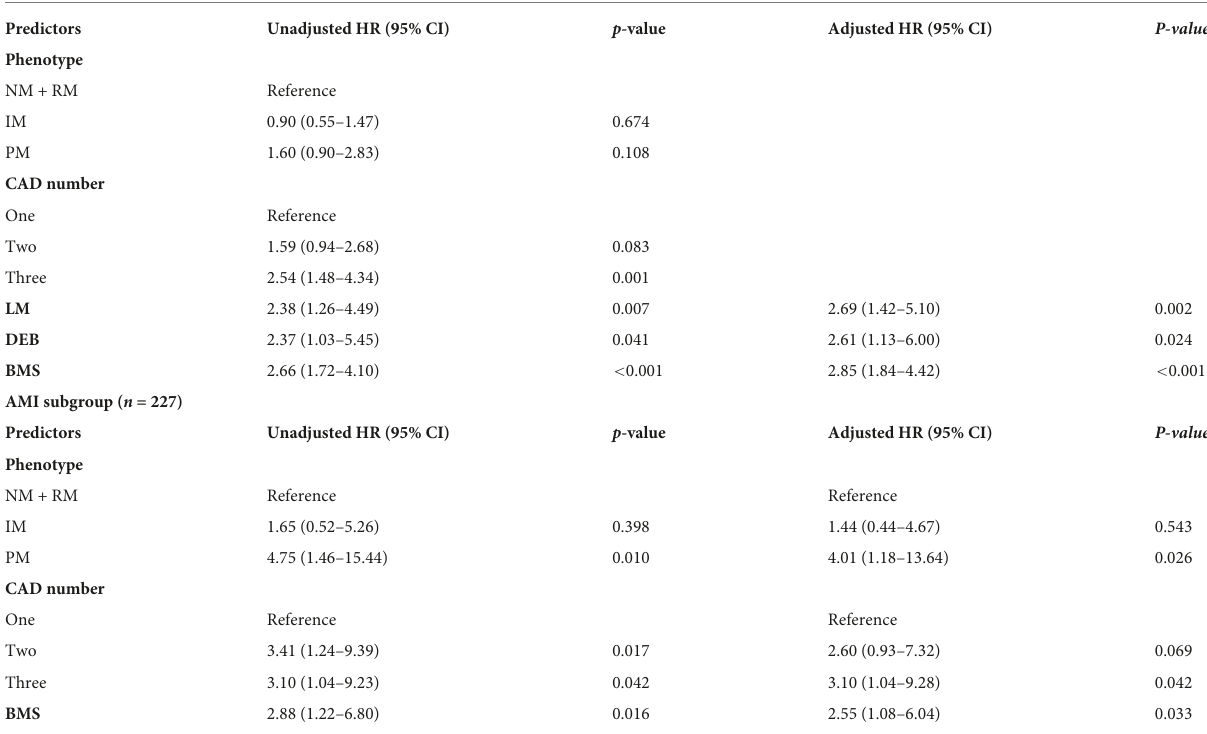
TABLE 5 Predictors of major adverse cardiovascular and cerebrovascular events (MACCE) during 1-year follow-up in all participants ( n = 999) and in the AMI